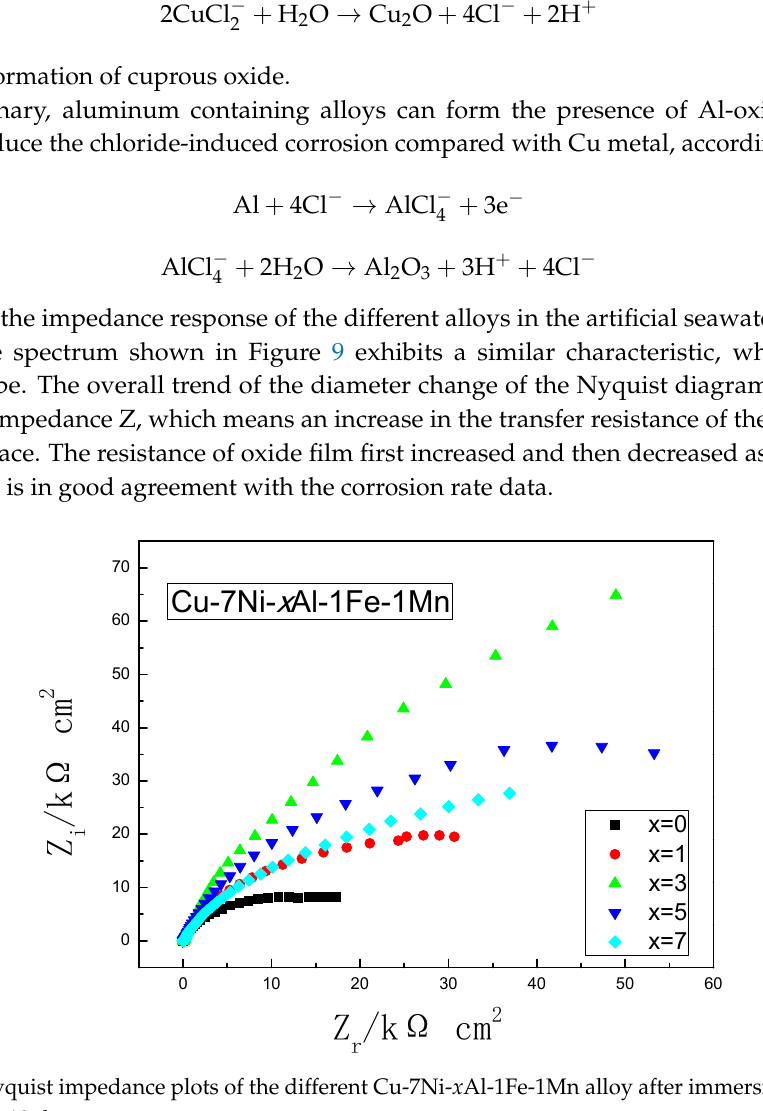
Figure 9. Nyquist impedance plots of the different Cu-7Ni- x Al-1Fe-1Mn alloy after immersing artificial seawater for 10 days.